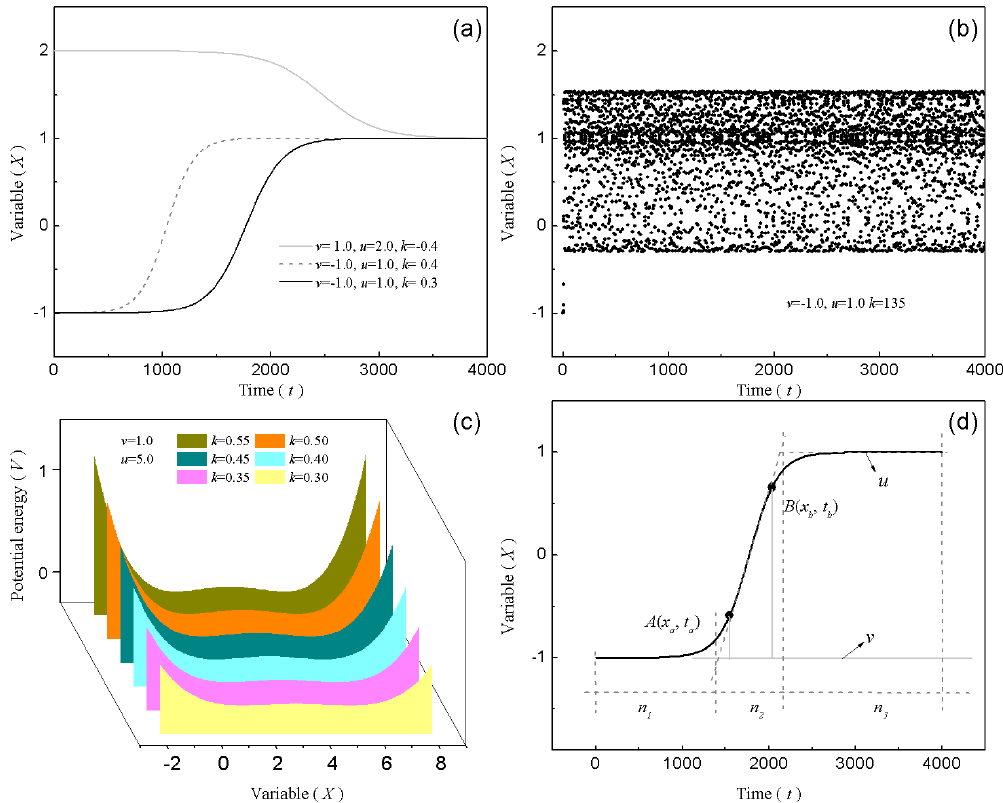
Figure 2. (a) The transition processes of the system swinging between different stable states since the parameters are different. (b) The system stays in unstable states. (c) The generalized potential energy function of the system performs differently since the parameters are different. (d) Different segments of the transition process in the ideal time sequence.